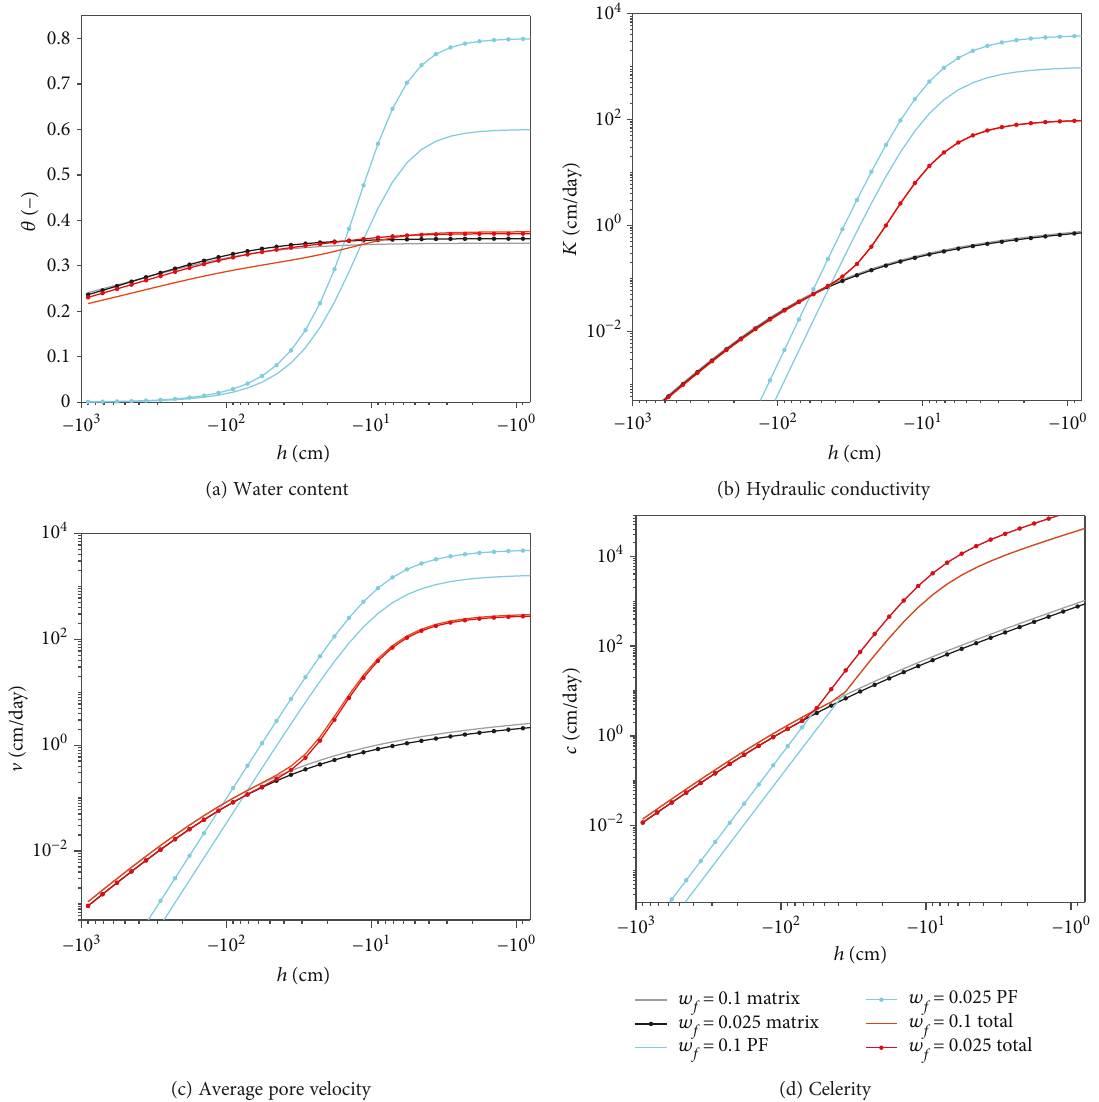
Figure 7: Under parameter settings of a single-continuum soil hydraulic model in Table 4, bimodal soil hydraulic functions of (a) water retention θ h , (b) hydraulic conductivity K h , (c) average pore velocity v h , and (d) celerity c h for matrix fl ow (matrix), preferential fl ow (PF), single-continuum model, and dual-continuum model (dual) are given,